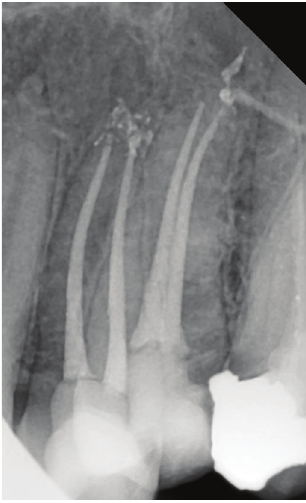
Figure 3: One root with two canals and two separate apical foramina.